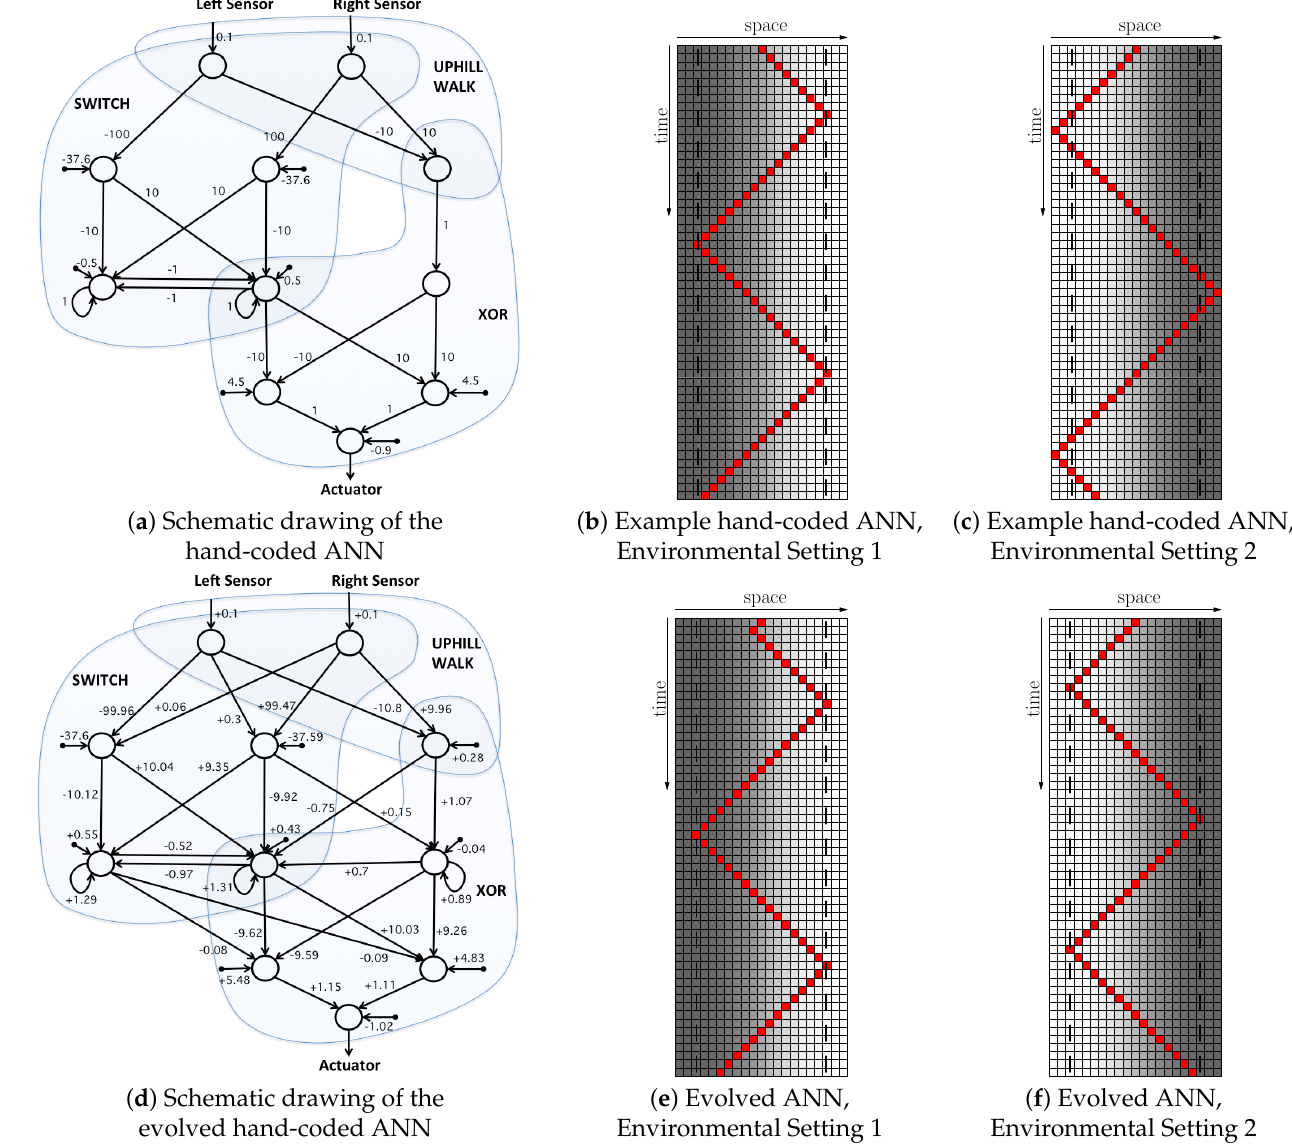
Figure 5. An example hand-coded ANN with sub-optimal fitness ( a ) is evolved to reach an ANN with the maximum fitness ( d